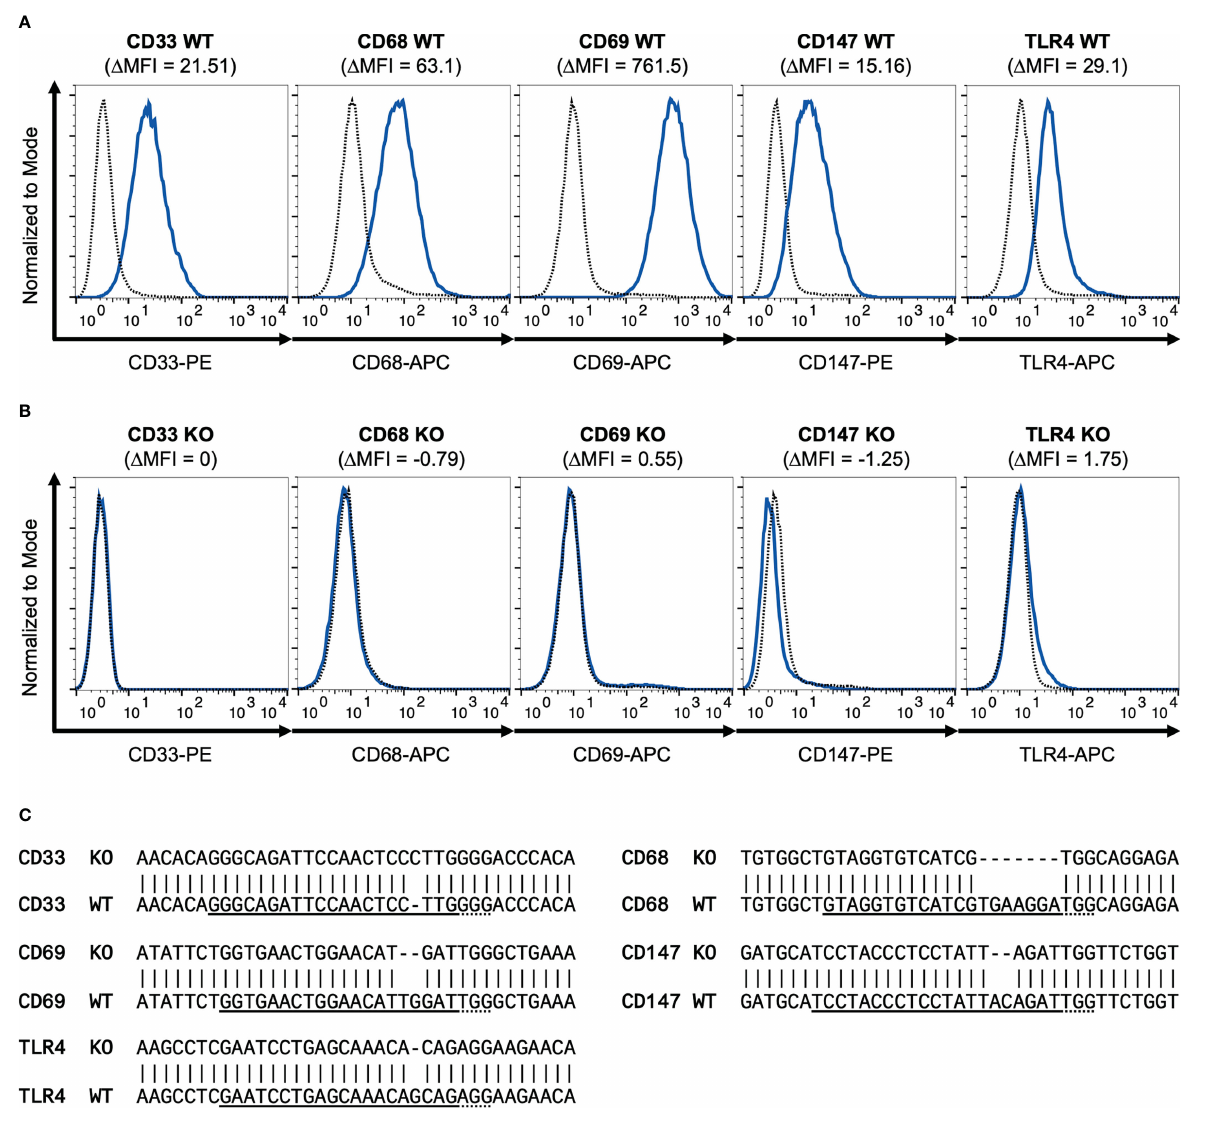
FIGURE 1 Validation of CD33, CD68, CD69, CD147 and TLR4 knockout. Flow cytometry histograms show WT (A) and different CRISPR/Cas9 knockout (B) ER- Hoxb8 precursor cells stained for surface CD33, CD68, CD69, CD147 and TLR4. Dotted lines represent corresponding isotype controls. Delta MFI values are calculated as differences of geometric mean fl uorescence intensities. (C) Representative sequencing results of PCR amplicons of genomic target regions cloned into pJET-vector are shown for knockout cell lines examined and compared with wild-type gene sequences. gRNA sequences are underlined. Dotted lines represent PAM sequences. Mismatches indicate